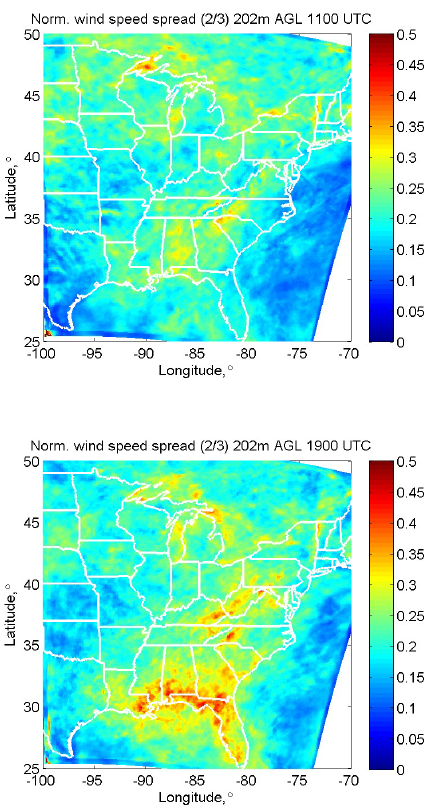
Figure 6: Wind speed spread in early morning and midday from the WRF ensemble. Spread is 553 Figure 6. Wind speed spread in early morning and midday from normalized by mean speed (therefore unitless) and averaged over all 49 days.554 the WRF ensemble. Spread is normalized by mean speed (therefore unitless) and averaged over all 49 days. Table 6. Comparison statistics of CO and CO tracer for all WP3 air- craft flights below 1000ma.s.l. Model points are extracted along the flight track every 10s, linearly interpolated in space and time, and then further averaged to 120s. r is the Spearman rank correlation coefficient. Number of samples is 1597.